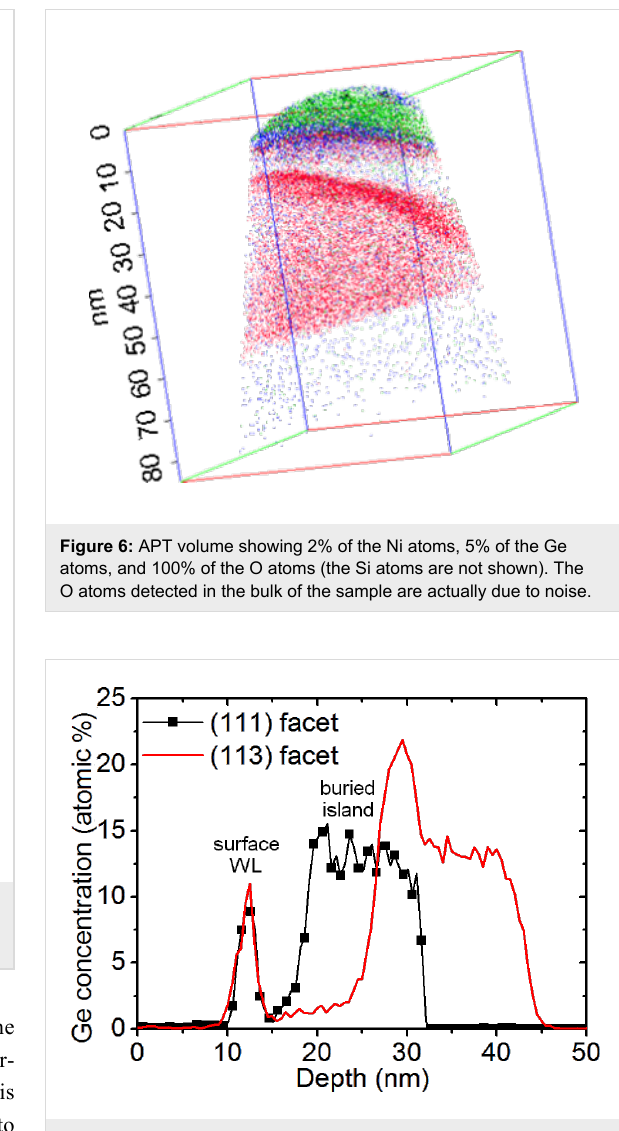
Figure 7: Top-down 1D Ge concentration profiles measured in two different APT volumes, one in the direction perpendicular to a (111) facet (black solid squares), and the other in the direction perpendic- ular to a (113) facet (red solid line).